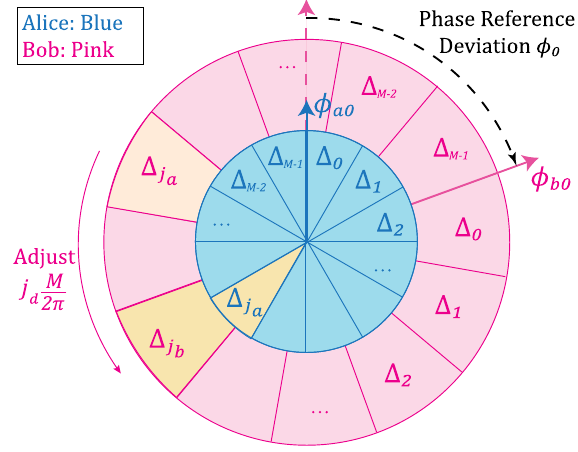
FIG. 2. Phase postcompensation. Without loss of generality, here we consider the case κ a ¼ κ b . Denote the phase references of Alice and Bob as ϕ a 0 and ϕ b 0 , and, hence, the reference deviation is ϕ 0 ¼ ϕ b 0 − ϕ a 0 mod 2 π . Bob can figure out the proper phase compensation offset j d by minimizing the QBER from random sampling as follows. Bob sets up a j d , sifts the bits by j j b þ j d − j a j ¼ 0 , and evaluates the sample QBER. He tries all possible j d ∈ f 0 ; 1 ; … ; M − 1 g and figures out the proper j d to minimize the sample QBER. Then, he announces the sifted locations of unsampled bits to Alice. As shown in the figure, we set M ¼ 12 , and the reference deviation ϕ 0 ¼ 70 °; hence, Bob can set j d ¼ 2 to compensate the effect of ϕ 0